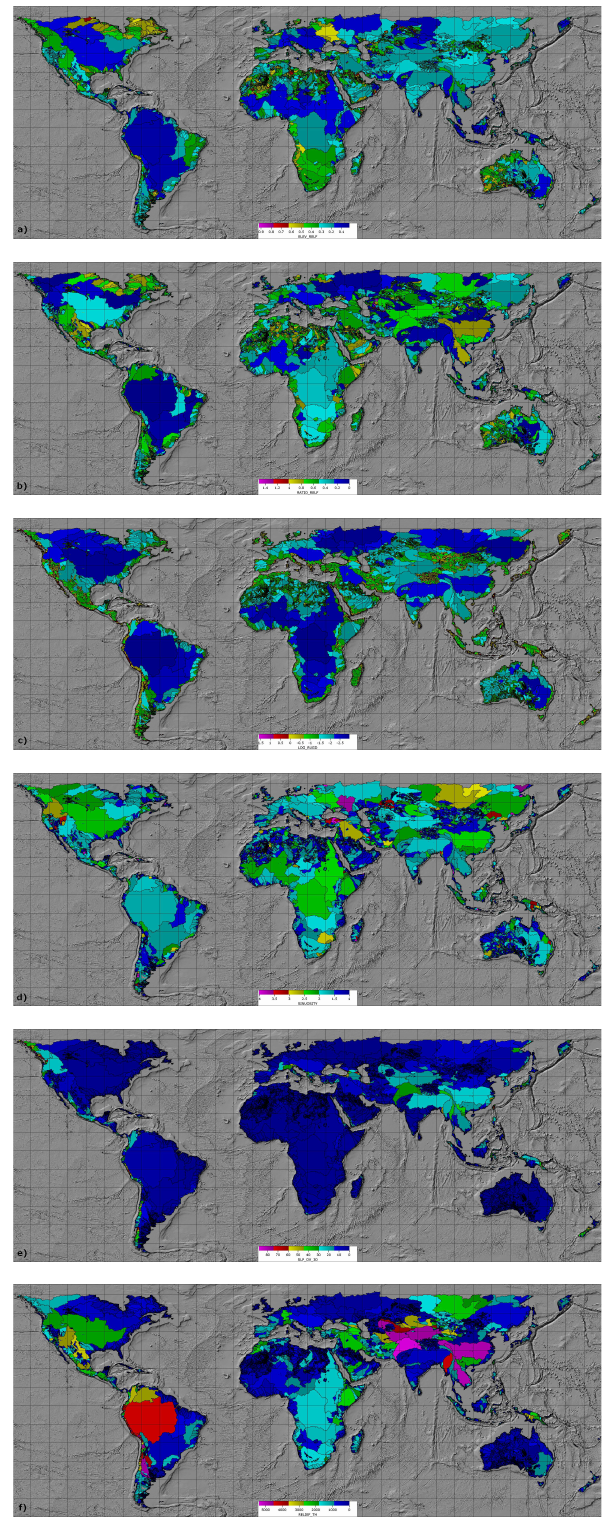
Fig. 5. Maps with drainage basin parameters. (a) ELEV RELF, (b) RATIO RELF, (c) LOG RUGD, (d) SINUOSITY, (e) percent- age of basin with slopes over 30%, and (f) relief of the main thal-